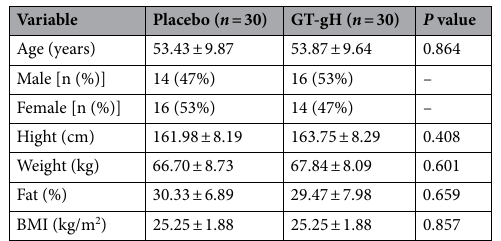
Table 1. Baseline characteristics of participants. Data shows Means ± SD. GT-gH, green tea with α-glucosyl hesperidin. P value were calculated by independent two-sample t test.